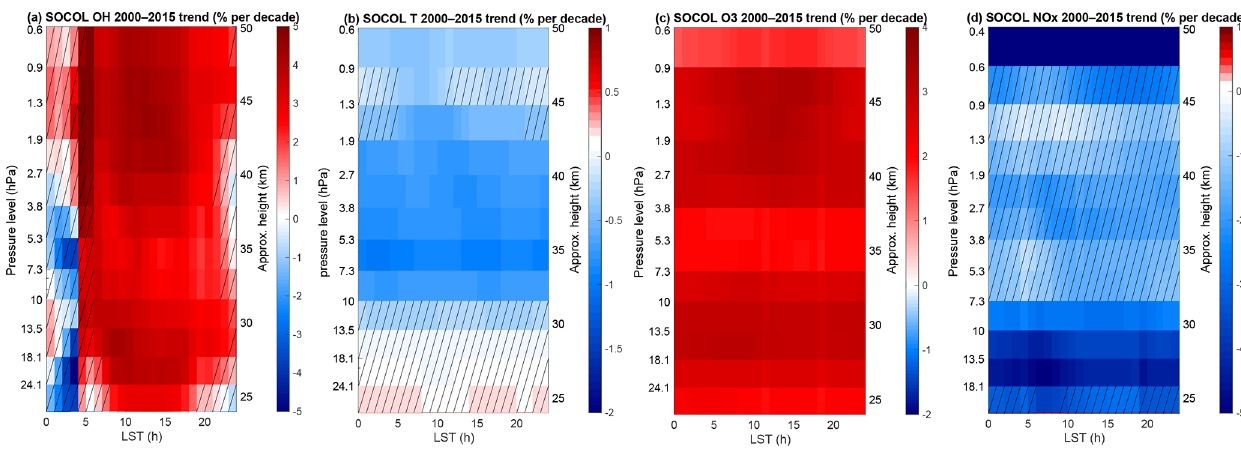
Figure 10. SOCOL v3.0 trends in percent per decade vs. LST (a) , OH trends (b) , T trends (c) , O 3 trends and (d) NO x